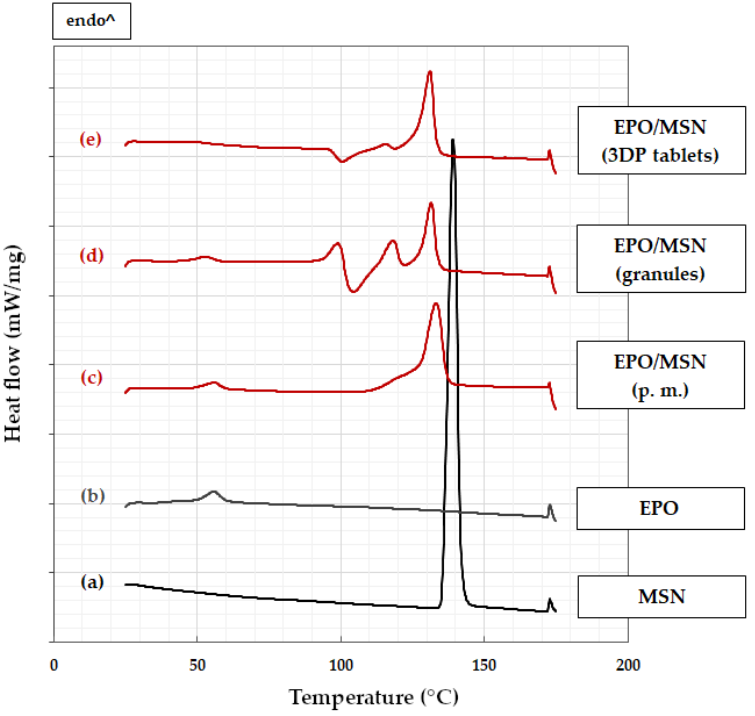
Figure 4. DSC measurements: ( a ) MSN; ( b ) EPO; ( c ) EPO/MSN physical mixture (p. m.); ( d ) EPO/MSN granules; ( e ) EPO/MSN 3D-printed tablets.